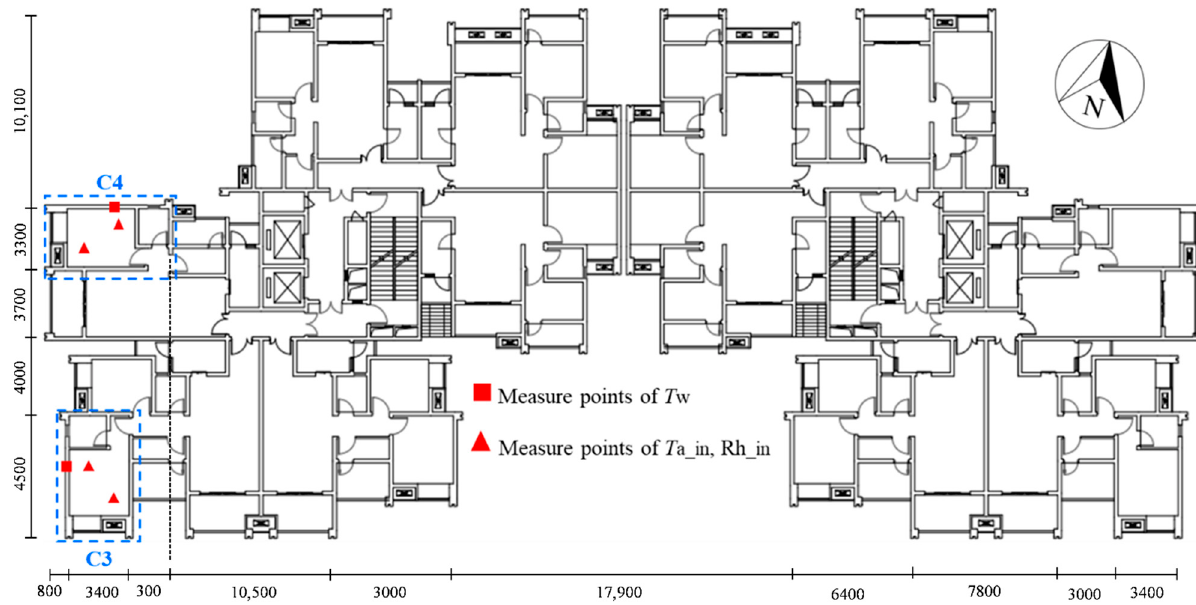
Figure 3. Locations of the tested rooms and measurement points for the wall temperature ( T w ), indoor air temperature ( T a _in), and relative humidity ( Rh_in ). Unit of dimensions in the figure is millimeter (mm).